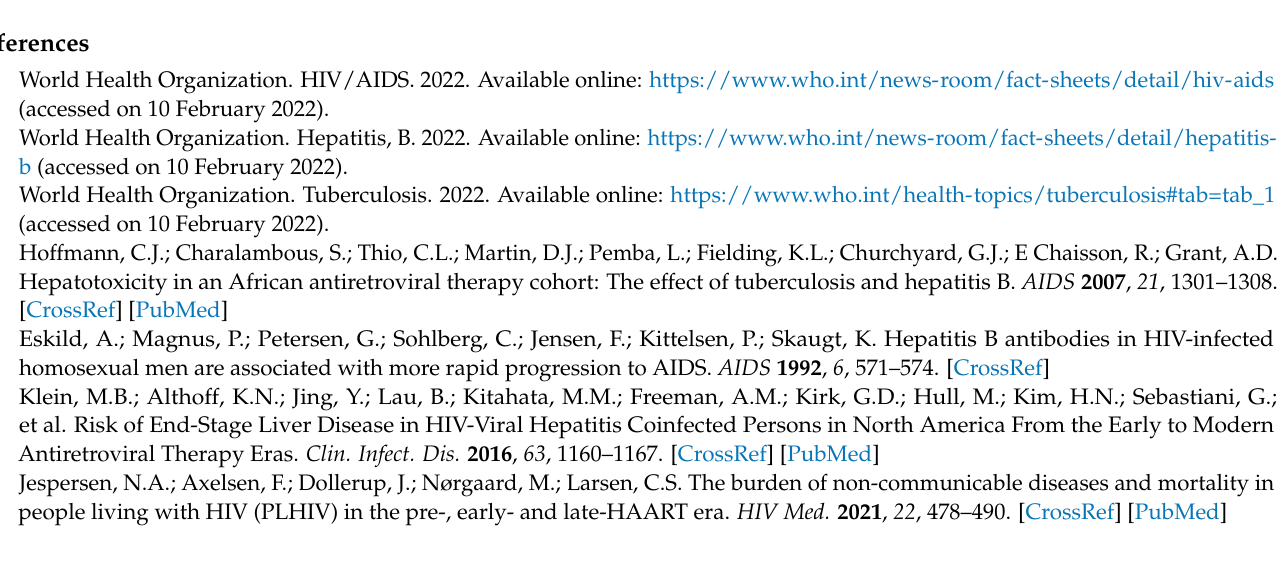
Table S2: Factors associated with renal impairment. Table S3: Factors associated with impaired glucose